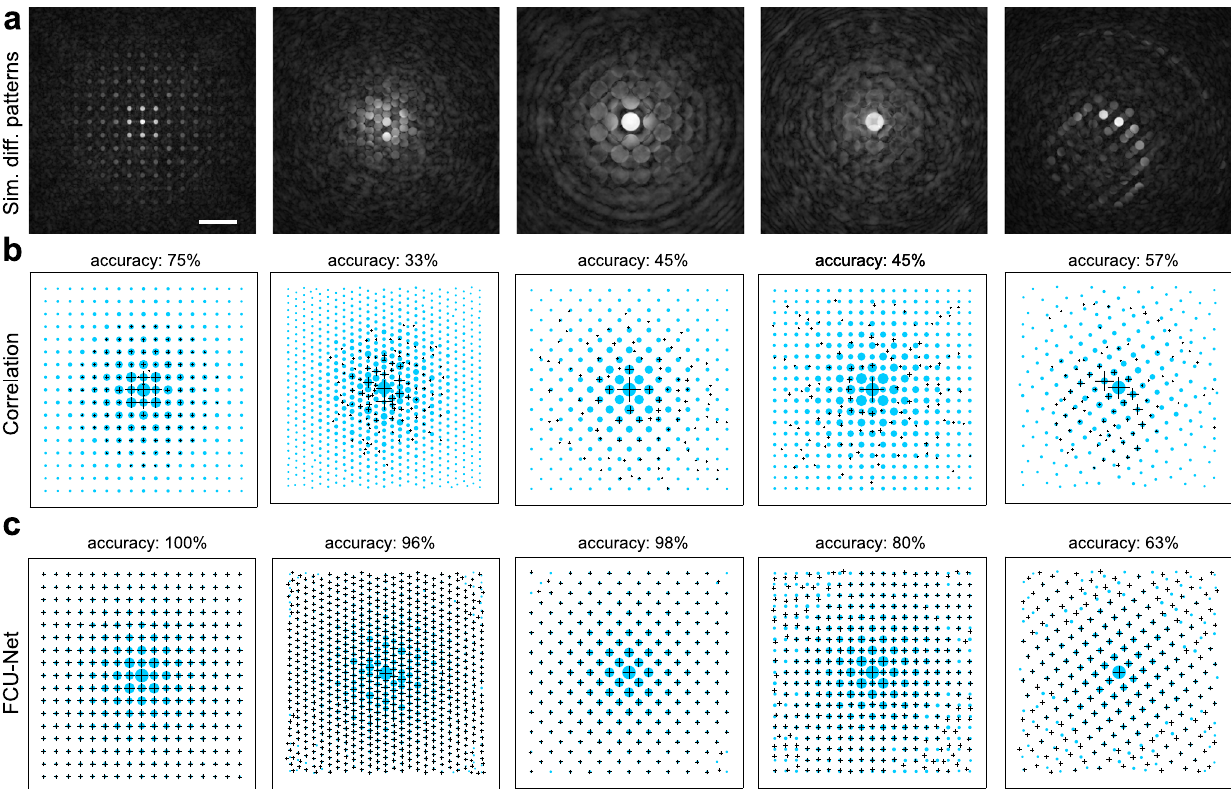
Fig. 2 Bragg disk detection using cross-correlation and deep-learning methods. a Examples of simulated diffraction patterns for crystals of different thicknesses and orientations. Scale bar is 0.5 Å − 1 . b , c The positions of the ground truth structure factor coef fi cients of the crystal lattice are plotted below as blue circles, with a size proportional to the structure factor amplitudes V g . The structure factor positions were computed using ( b ) template matching by cross-correlation with the vacuum probe signal, and ( c ) the FCU-Net network. Both measurements are overlaid as black crosses, with a size proportion to the estimated disk amplitude (square root of the disk intensity) and V g amplitudes, for the correlation and FCU-Net predictions, respectively. The total intensity-weighted accuracy is listed above for all The fi fth diffraction image in Fig. 2a is an example of an experiment where the sample, which has been tilted away from the low-index zone axis relative to the beam direction, creating complex variation in disk intensities due to tilt of the Ewald sphere. FCU-Net still outperforms cross-correlation in this case, though the gains here are more modest. We further evaluated the performance of FCU-Net and correlation methods for strain mapping by applying them to 415 unique crystals and orientations in our simulated dataset. These simulations were selected because they produced diffrac- tion patterns with at least two strongly excited non-orthogonal Bragg vectors (i.e., the diffraction pattern was 2D rather than 1D), and had enough separation between the diffraction spots to automatically detect the ground truth lattice from the structure factor images, which was determined by applying a threshold of 5% to the mean strain error. To avoid the introduction of biases, we used a single set of parameters, which generalized well across the entire dataset, rather than tailoring to a speci fi c diffraction pattern series. The performance of each method was evaluated by calculating the mean absolute value of the two principal strains. We initially analyzed low-index zone axis and randomly oriented crystals separately, but found negligible difference between the two. After disk detection and lattice assignment, we calculated the relative strain between the disk positions measured in the diffraction patterns and the positions measured from the structure factor images. The median of the strain error as a function of sample thickness from 2 to 50 nm is shown in Fig. 3a. We also show the 25th and 75th percentile range. FCU-Net outperforms the correlation